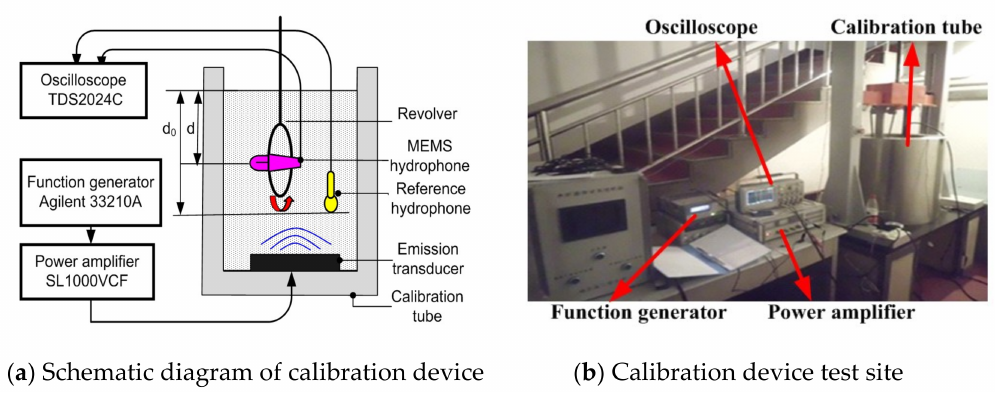
Figure 11. The diagram of calibration device and its